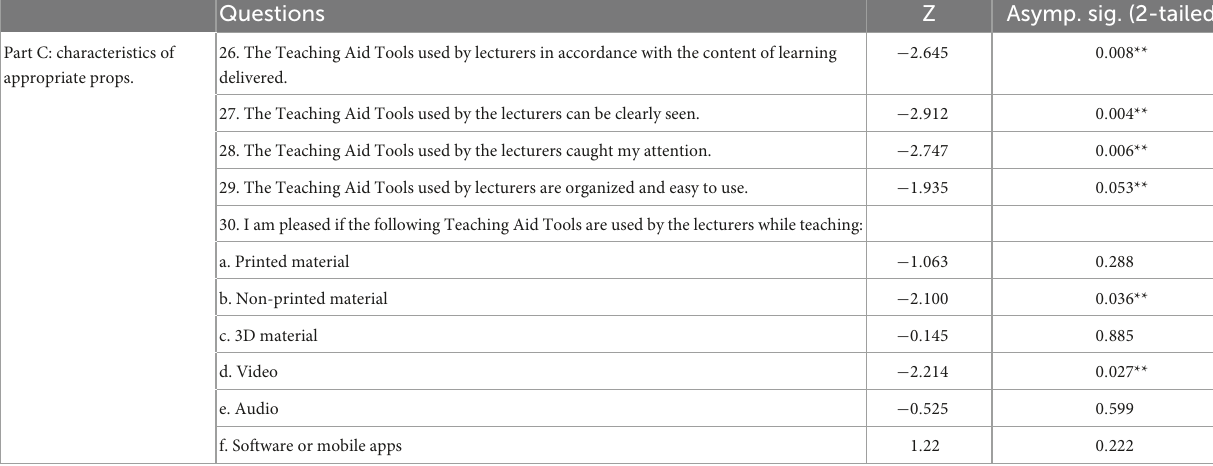
TABLE 4 Non-parametric test using Wilcoxon signed-rank rest (Part C). Questions Part C: characteristics of appropriate